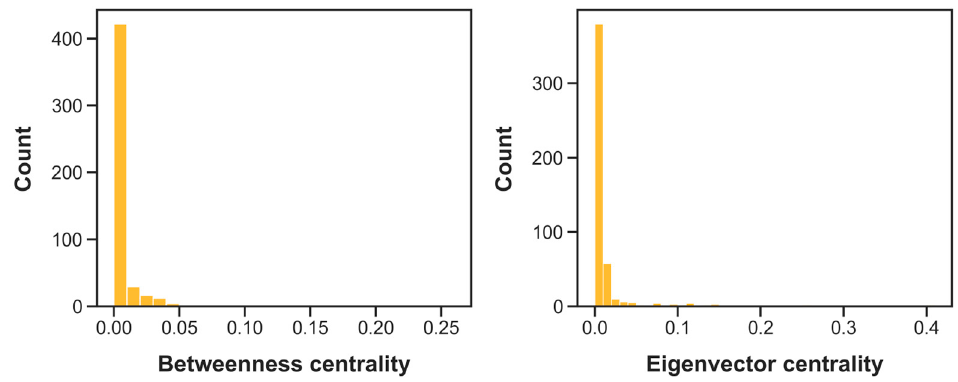
Figure 9. Histogram for the betweenness and eigenvector centrality values.